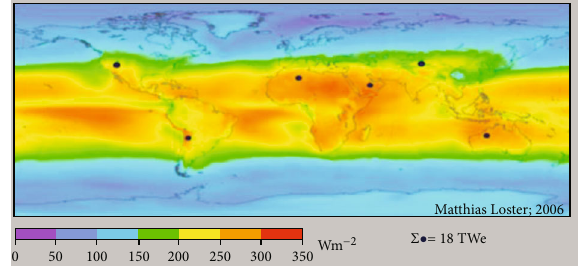
Figure 4: High capacity of solar energy